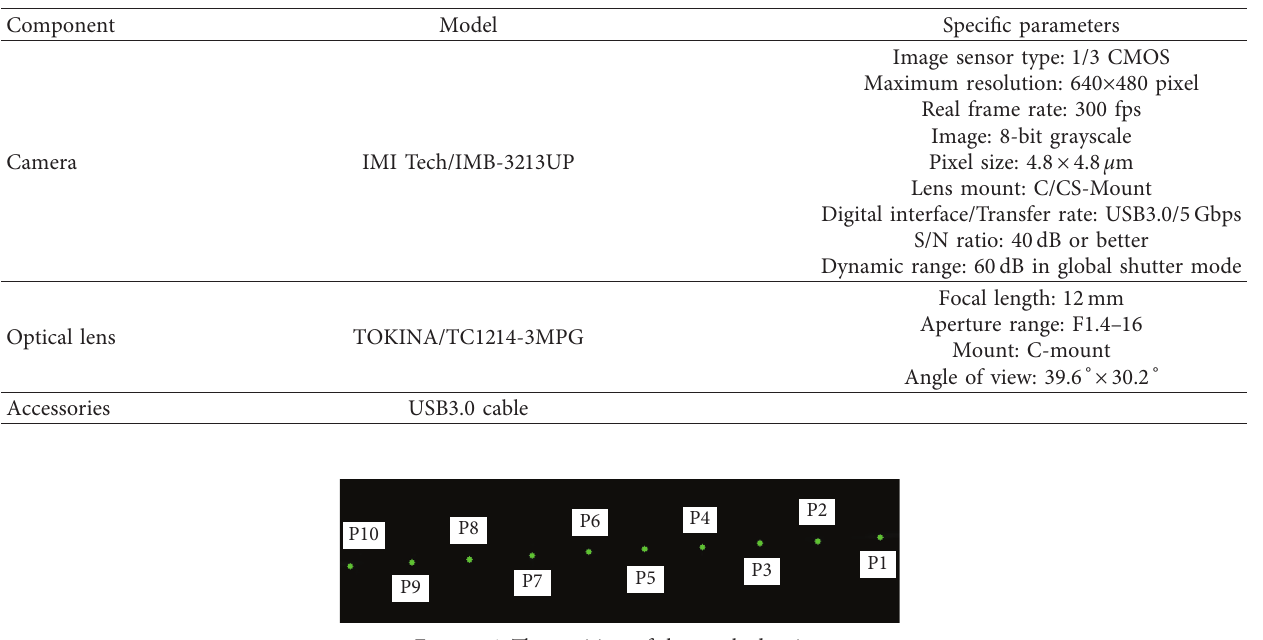
Figure 6: The position of the marked points.